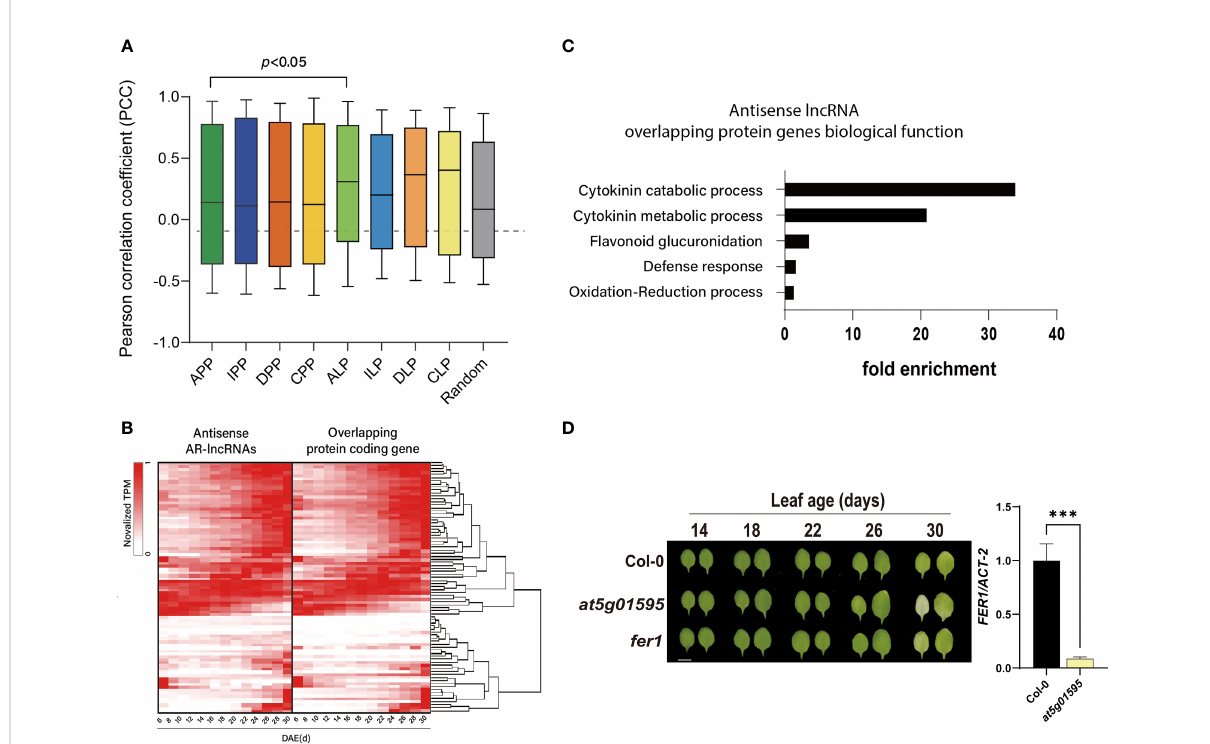
FIGURE 3 Expression correlation of antisense AR-lncRNAs and overlapping protein-coding genes during the leaf lifespan. (A) Box-plot displaying the expression correlation between AR-lncRNAs and adjacent genes. PCC: Pearson correlation coef fi cient; APP: overlapping protein-coding gene pairs; IPP: protein- coding genes and non-overlapping protein-coding gene pairs; DPP: divergent protein-coding gene pairs; CPP: convergent protein-coding gene pairs; ALP: antisense AR-lncRNAs and overlapping protein-coding genes; ILP: intergenic AR-lncRNAs and non-overlapping adjacent genes; DLP: divergent AR-lncRNAs and adjacent genes with a common promoter region; CLP: convergent AR-lncRNAs and adjacent genes within 1,000 bp; Random: random pairs. Central lines represent the mean. Whiskers represent the maximum and minimum values. Statistical difference is indicated by p-value (Mann- Whitney U-test. (B) Heat maps representing the expression pattern of antisense AR-lncRNAs and overlapping protein-coding genes. Rows are ordered based on hierarchical clustering. Columns indicate the number of days after emergence (DAE). Color bar shows the fraction density during the leaf lifespan. (C) Gene ontology biological process [GOBP of protein-coding genes overlapped with antisense AR-lncRNAs (p < 0.05)]. Fold enrichment represents the ratio of the proportion of input genes involved in GOBP and the proportion of genes in the given GOBP in involved in the background. (D) Phenotype of Col-0, at5g01595 and fer1 during developmental leaf senescence (left) and expression level of FER1 mRNA was measured by qRT- PCR (right). Data in the right panel represent the mean of 3 biological replicates, and error bars represent SD (n = 3). Asterisks indicate signi fi cant differences (t -test; ***, p <